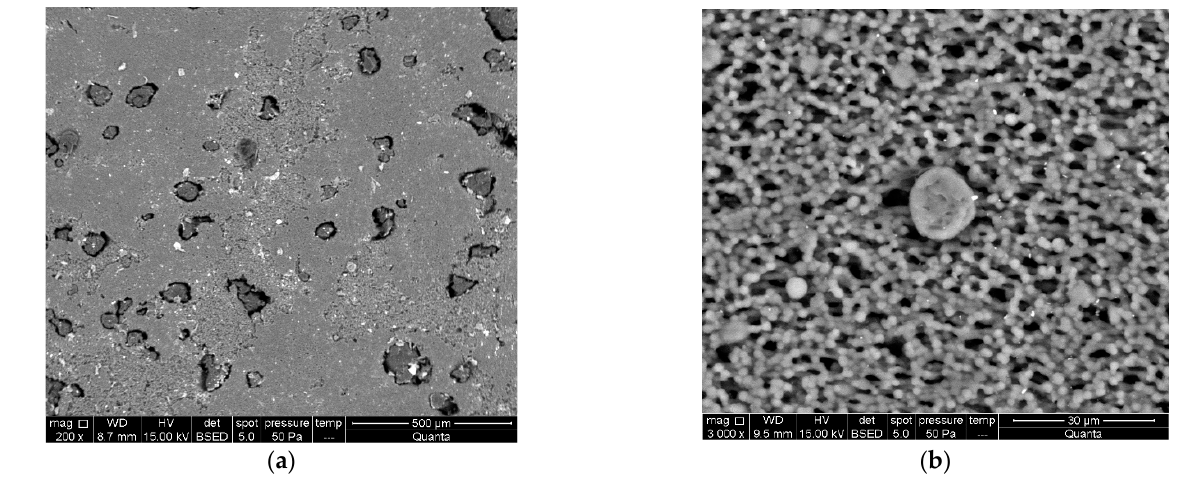
Figure 3. SEM photos of filler distributions for the E-1.1-20 at 200× magnification ( a ) and for the E-1.05-15 at 3000× magnification ( b ).